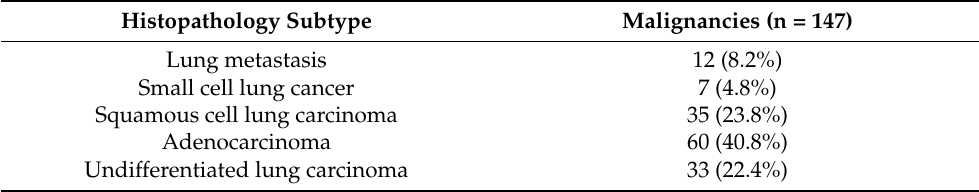
Table 2. Malignancies histopathology subtypes.